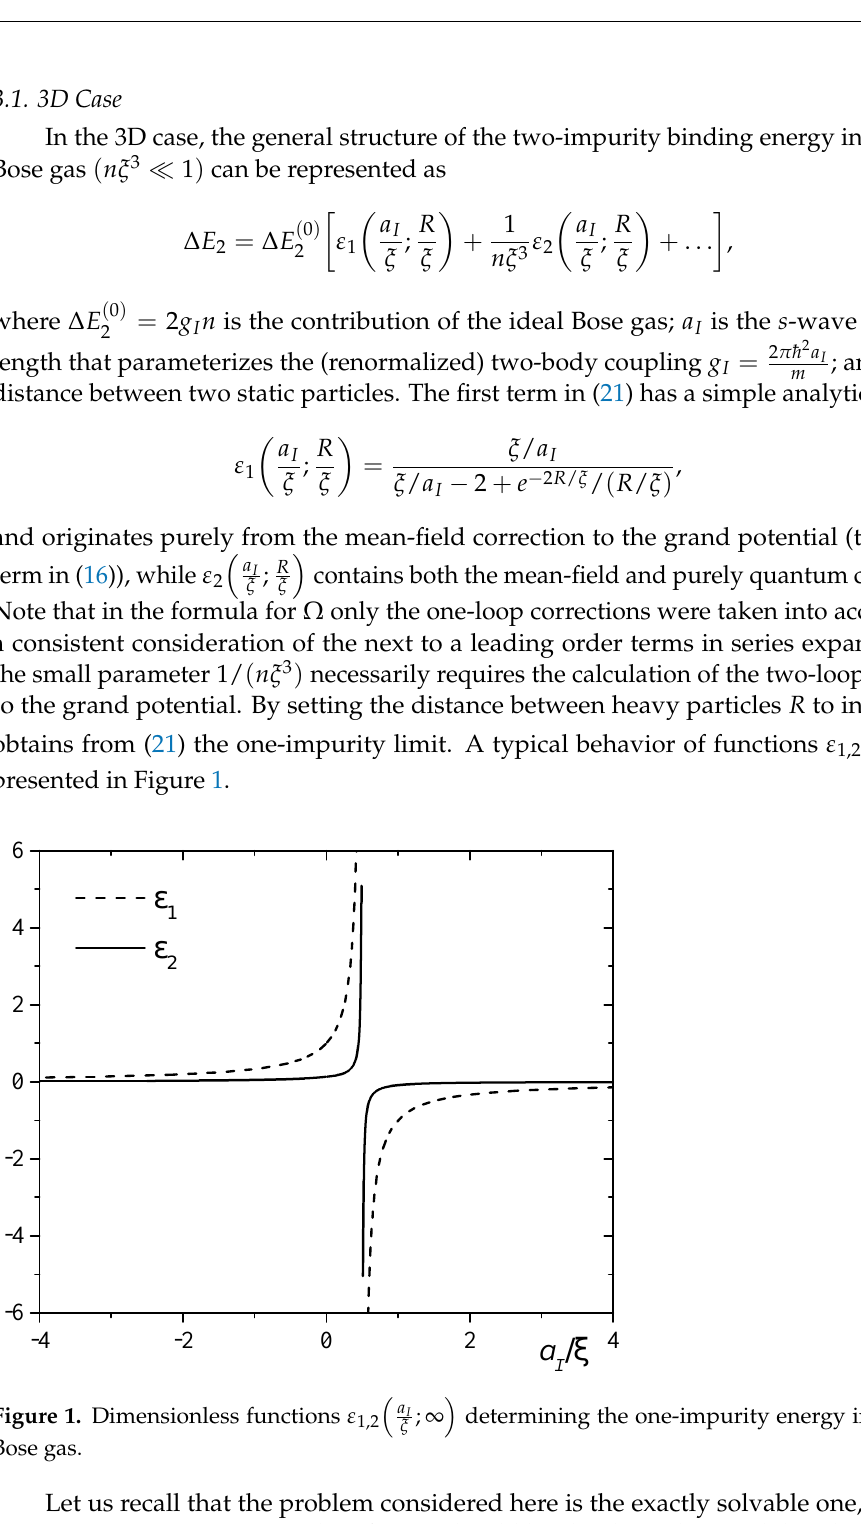
Figure 1. Dimensionless functions ε 1,2 Bose